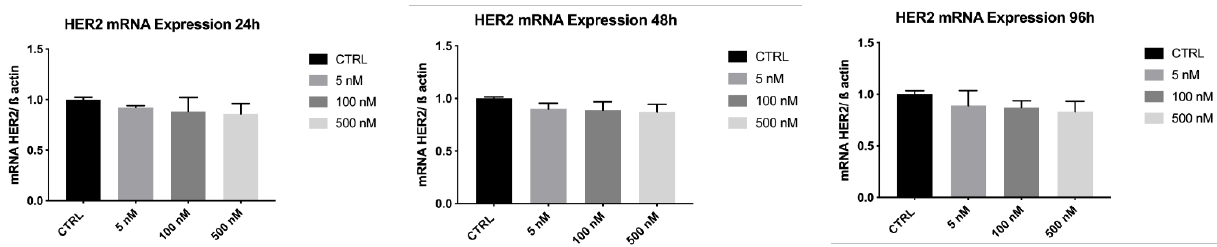
Figure 9. Effect of Z HER2:2891 DCS-MMAE on HER2 expression in MDA-MB-231cells. Cells were treated for 24, 48, and 96 h. The one-way ANOVA test did not reveal statistically significant differences between the control and treatments. Data are presented as mean ± SEM.